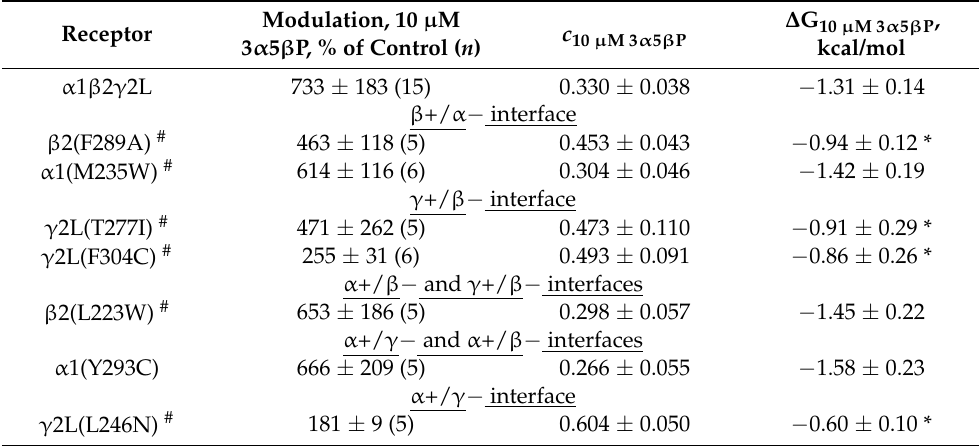
Table 3. Summary of effects of mutations on GABA A receptor potentiation or direct activation by 3 α 5 β